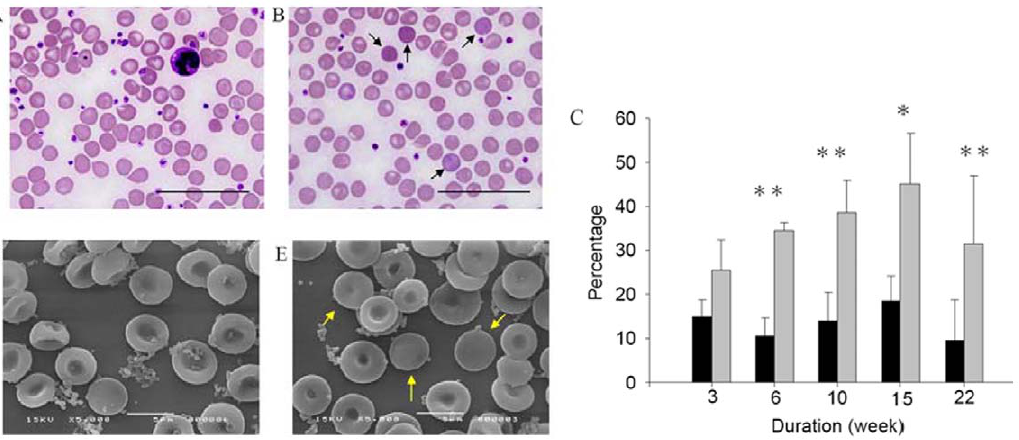
Figure 1. Morphology of RBCs from cellulose- (A, D) and garlic-supplemented (B, E) diet groups. RBCs were stained with Giemsa (week 6) to show darkly-stained cells (arrows in Panel B). (A) Most RBCs of control samples stained intensely around the edges rather than in the middle, reflecting their bi-concave shape. Among the uniform-sized RBCs are many small platelets and a neutrophil with a multi-lobed nucleus. (B) Darkly- stained RBCs in garlic-fed samples are non-nucleated, round or ovoid-shaped cells (arrows in Panel B) with almost the same size as the RBCs in control samples. They have more intense colors with a dark blue tint. (C) The % difference of darkly-stained cells at each time point (mean 6 s.e.m., n=3–4, Brilliant Cresyl blue staining) between the two diet groups (control:black bars; garlic:gray bars) is significant (student’s t test: *, p , 0.05; **, p , 0.01) throughout the time course. (D and E) SEM of RBCs (5000 6 ) from control (D) and garlic-fed (E) mice (week 17). RBCs of garlic-fed samples contain more round-shaped cells (arrows in E) and those with a smaller dent at center. Scale bars: 100 m m (Panels A and B) or 5 m m (Panels D and E).